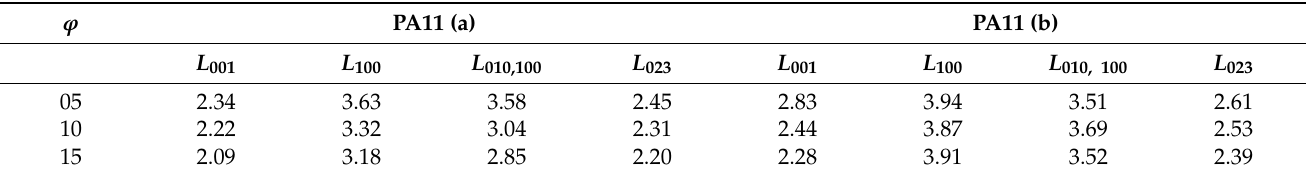
Table 4. L hkl to different crystal planes of PA11 samples with different cooling